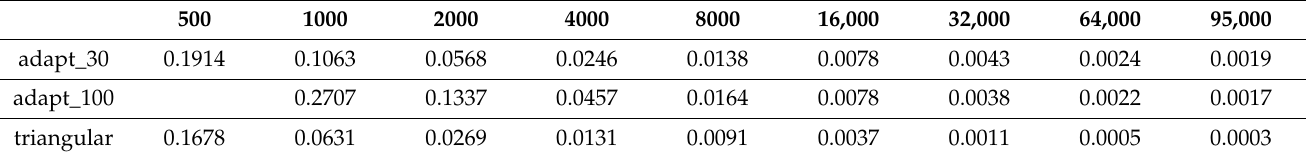
Table 3. The mean in mm of the simplified models for each simplification method compared to the high-resolution one.